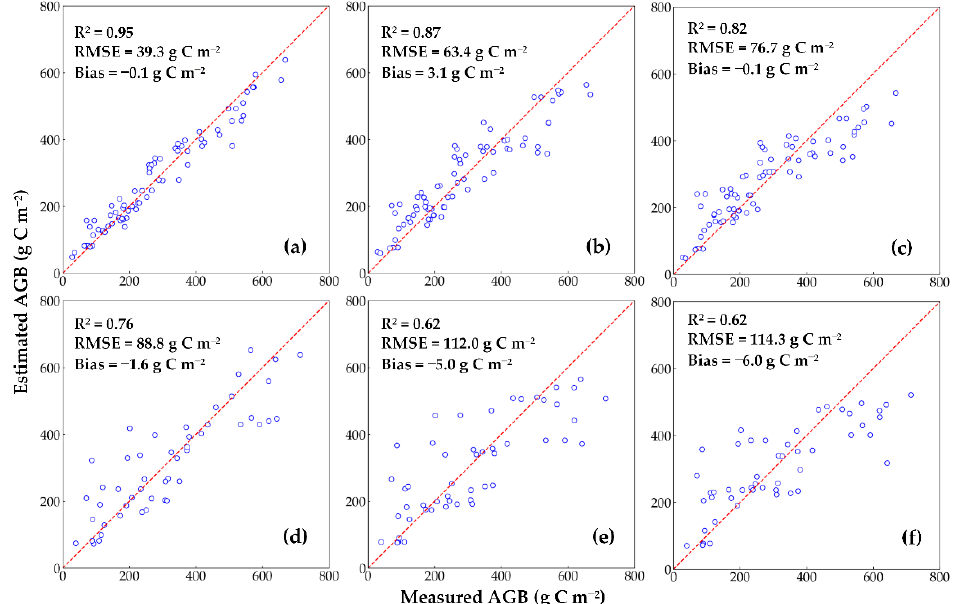
Figure 3. Scatter plots for AGB ground observations and estimations from ( a ) GBRT, ( b ) RF, ( c ) ERT using training set and ( d ) GBRT, ( e ) RF, ( f ) ERT using validation set.